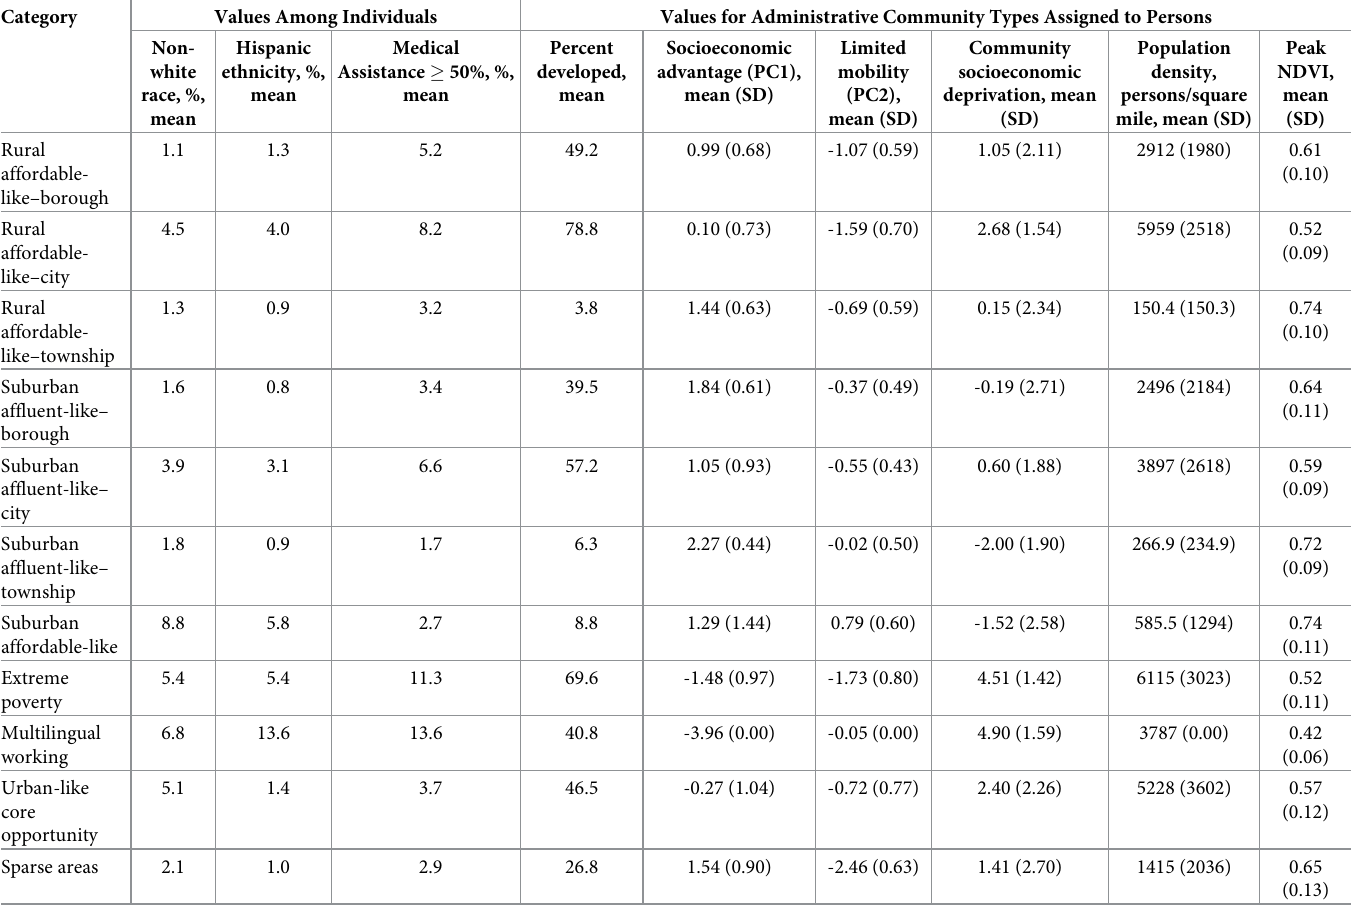
Table 4. Selected summary statistics by modified typology categories among 95,323 cases and controls.